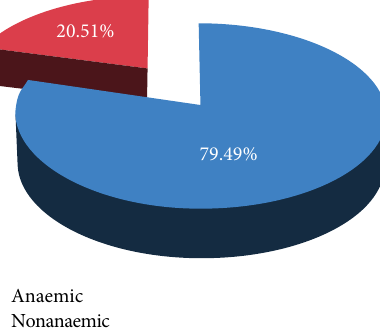
Figure 2: Prevalence of anaemia.